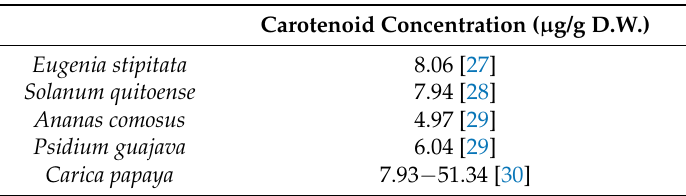
Table 2. Carotenoid concentration in tropical fruits. Carotenoid Concentration ( µ g/g